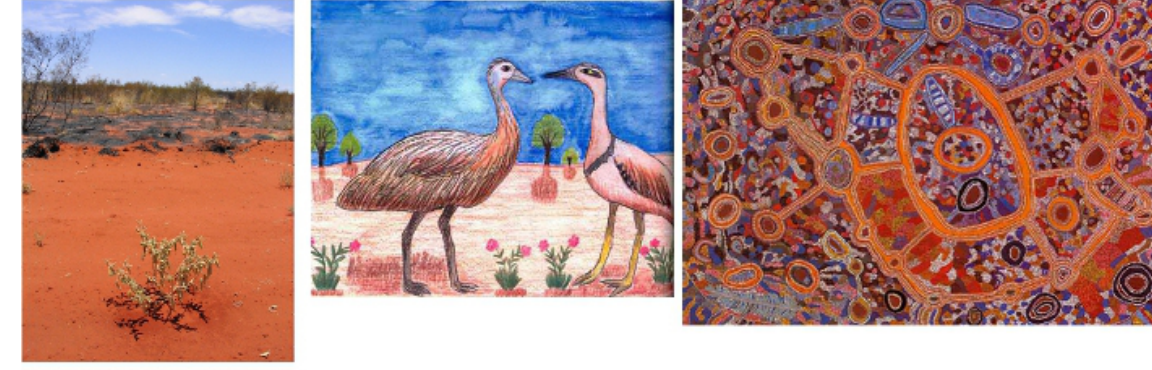
Fig. 9. The Akatyerre (Desert raisin) species selected to illustrate all three domains. (Left) On country, the production of Akatyerre is managed by fire that stimulate its regrowth and fruiting; (middle) On country in the Altyerr (Dreaming), the Emu and Turkey (Australian bustard) engaged in disputes over Akatyerre fruit. Biologically, the fruits are a favored food of these large birds also prized by Aboriginal hunters (Painting by Tilmouth and Abbott 2007); (right) Painting that depicts the creation ceremony for Desert raisin at Wirrirrpi on Ngaanyatjarra country (1.3 x 1.8 m painting © Pulpuru Davies, 1993, reproduced by kind permission Warburton Arts